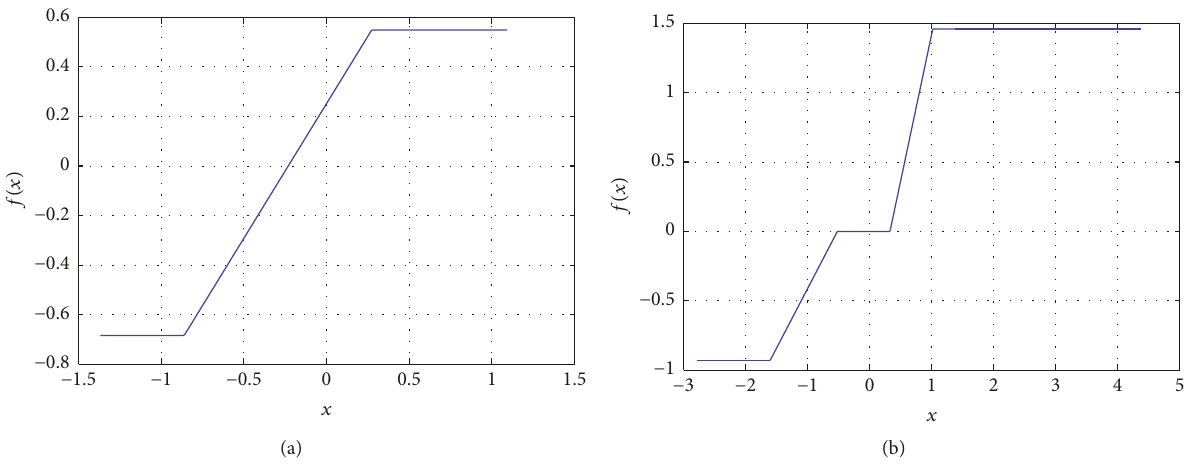
Figure 2: Examples of irregular SNLFs with (a) 2 and (b) 3 saturated